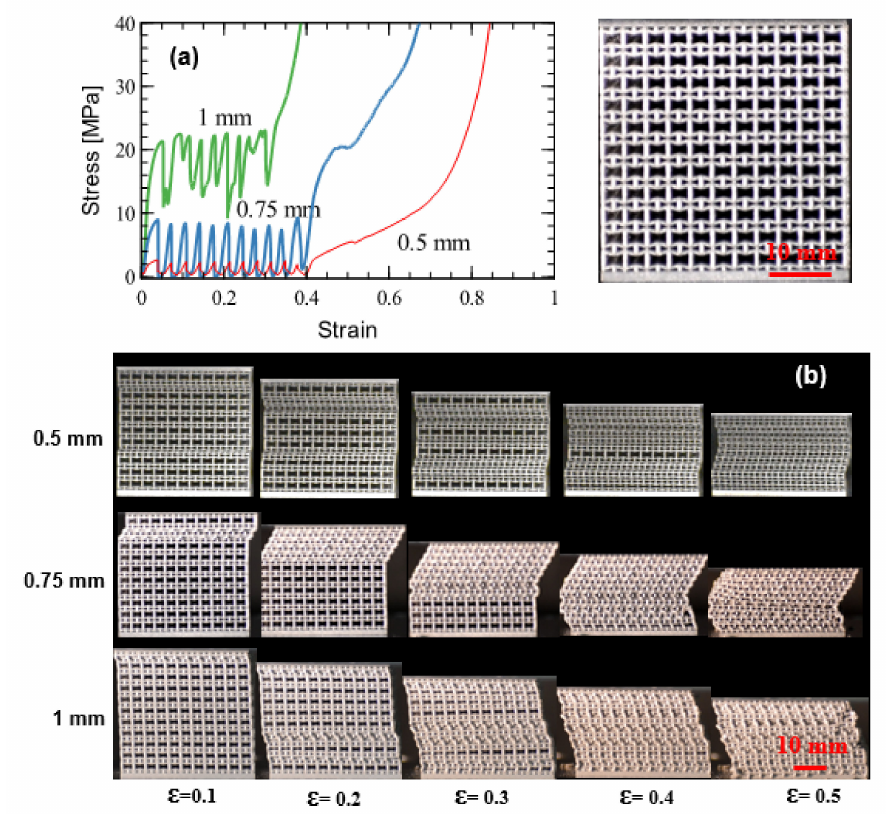
Figure 8. ( a ) Stress–strain curves for an auxetic lattice shape under compression with 0.5, 0.75, and 1 mm beam diameters, ( b ) auxetic lattice deformation sequence for each of the three beam diameter specimens at increasing strain.